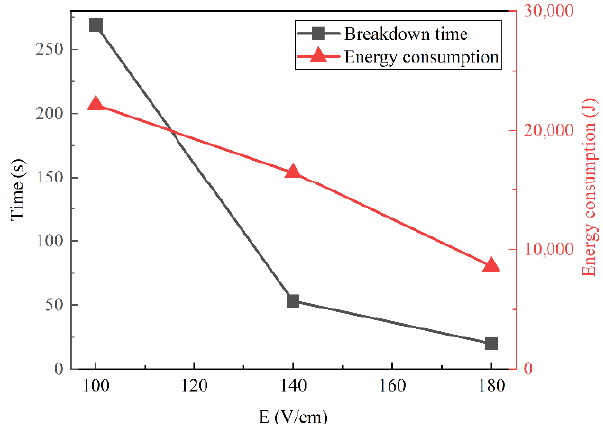
Figure 7. Changes in the breakdown time and energy consumption with different electric field intensities.